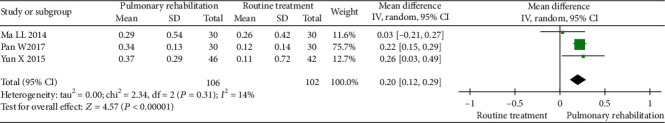
Forest plot showing the effect of PR on the FVC for pneumoconiosis.